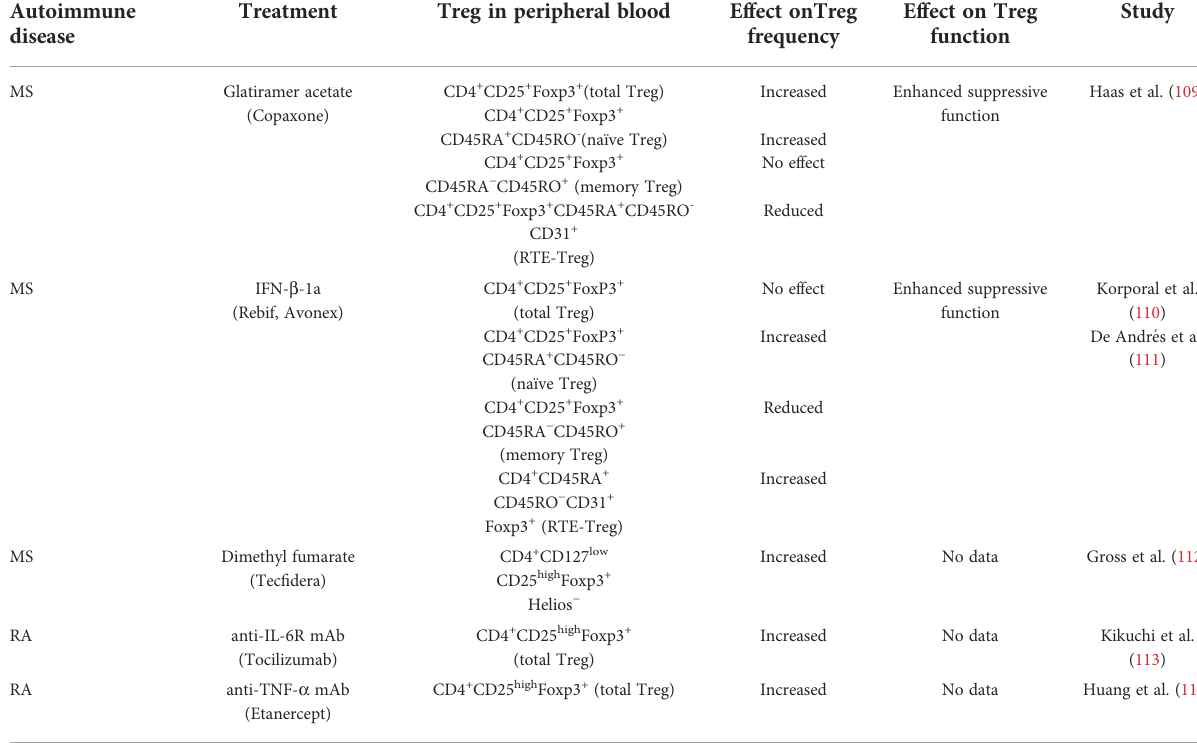
TABLE 2 Effect of immunomodulatory drugs on Treg frequency and function in MS and RA